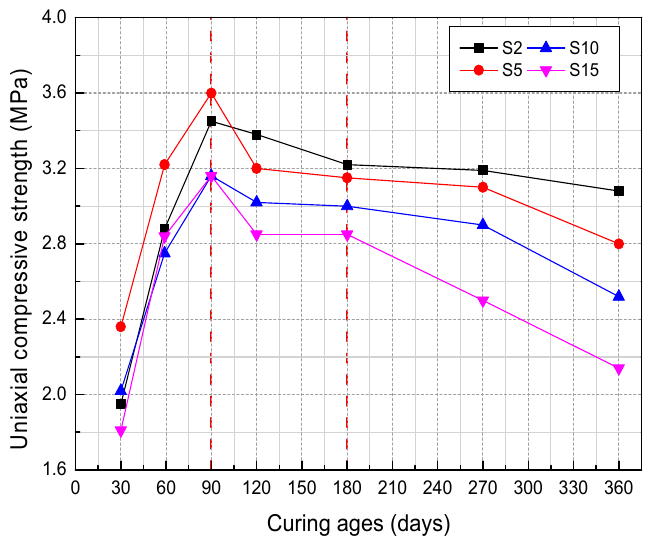
Figure 9. The UCS of samples with different sulfur content [37].